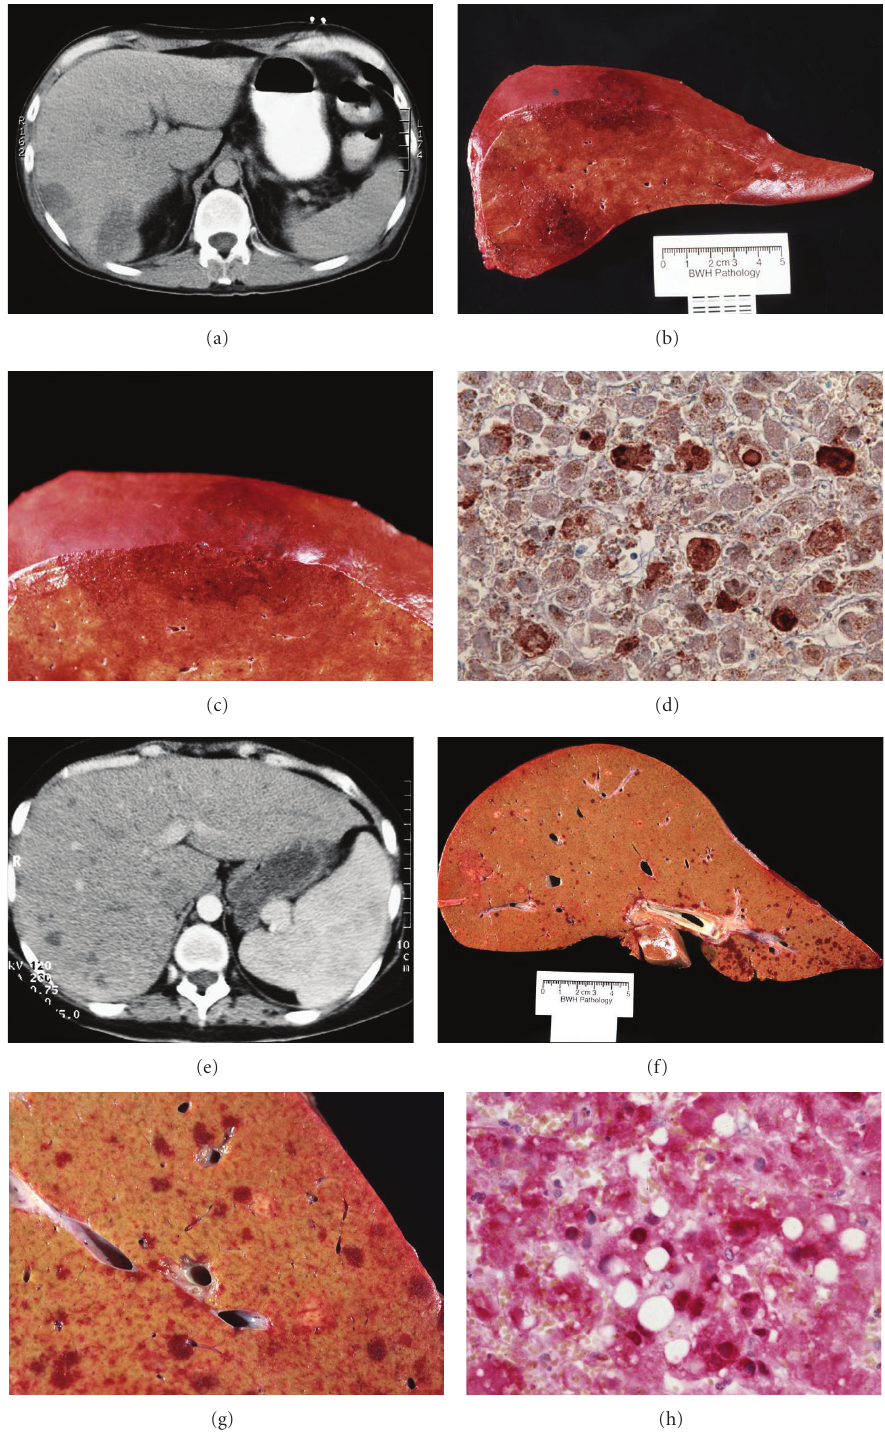
Figure 1: Radiographic and pathologic appearance of adenovirus infection of the liver. (Patient 1: Panels (a)–(d)) CT of the abdomen (a) showed two large hypodense lesions in the liver. On post-mortem examination, the liver had multiple large areas of necrosis ((b) and (c)). Immunohistochemistry of thin sections of the liver confirmed the presence of adenovirus (d). Subsequent testing revealed adenovirus, serotype 5. (Patient 2: Panels (e)–(h)) CT of the abdomen showed multiple small hypodense lesions in the liver (e). The liver had multiple small areas of necrosis ((f) and (g)). Immunohistochemistry of the liver confirmed the presence of adenovirus (h). Subsequent testing revealed adenovirus, serotype